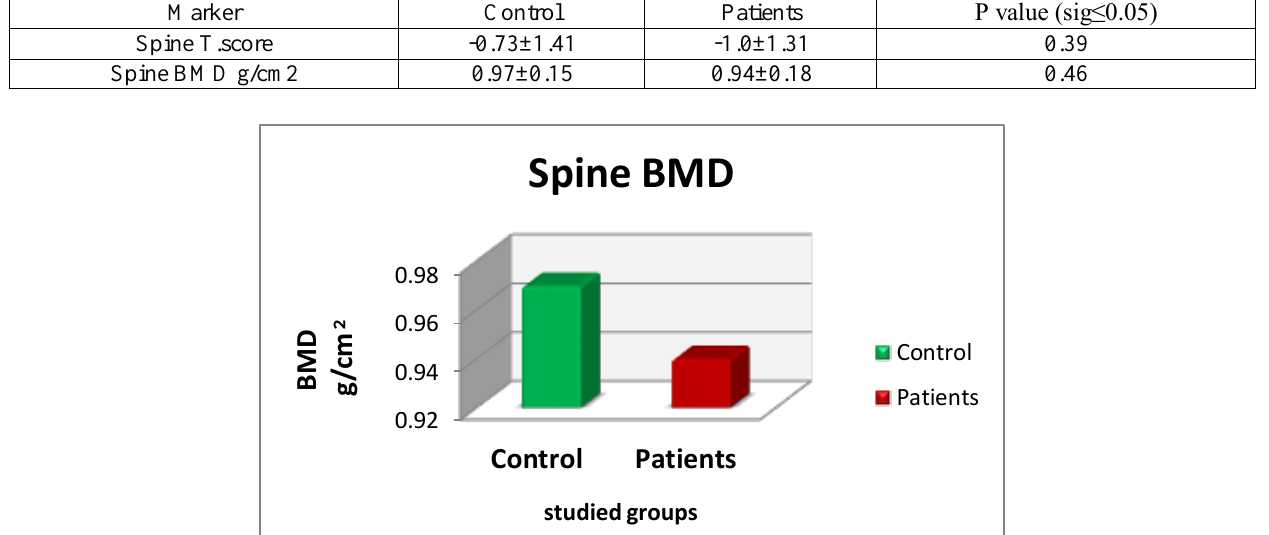
Table 4: Measurements of spine bone mineral density and T.score.